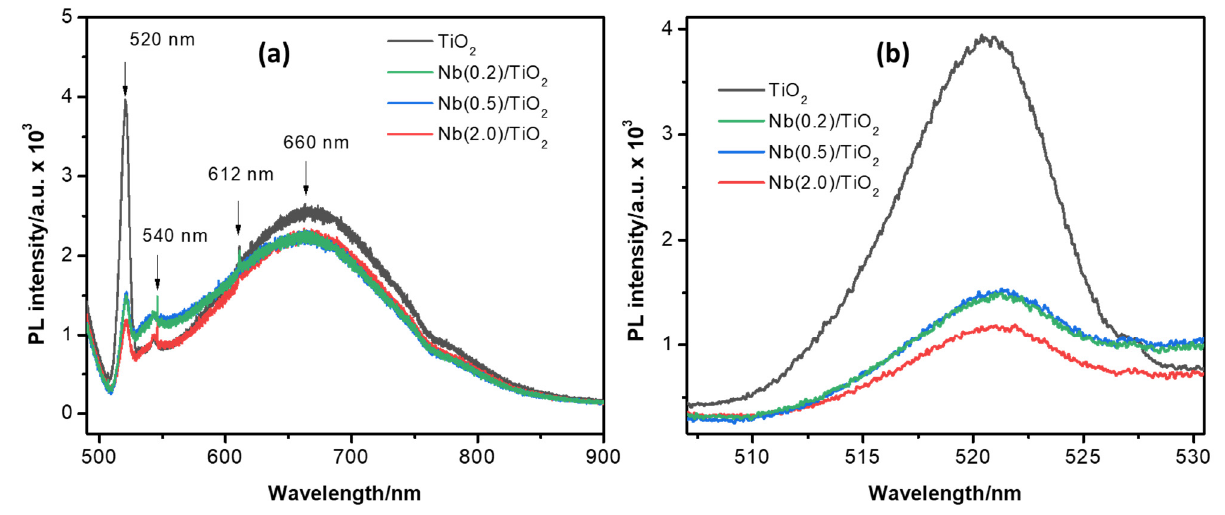
Figure 6. ( a ) PL spectra of pure TiO 2 and Nb(x)/TiO 2 nanocomposites. ( b ) Zoom-in of the PL spectra around the peak located at 520 nm.